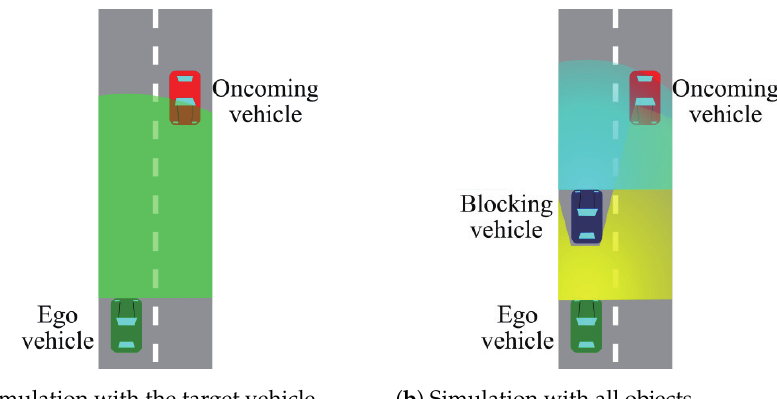
Figure 8. The two configurations for the recognition score.